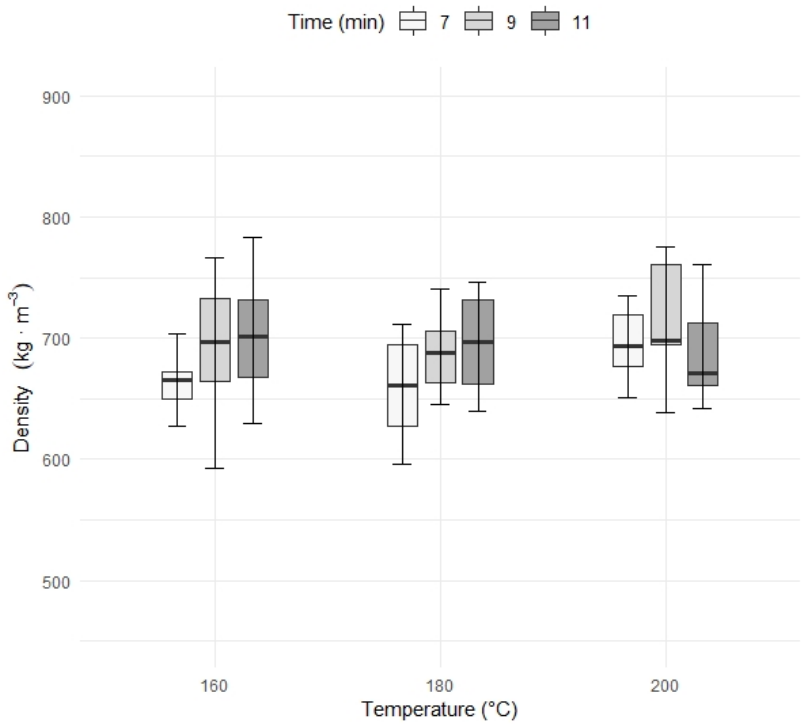
Figure 3. Density box char plot in function of pressing time and temperature. The whiskers represent